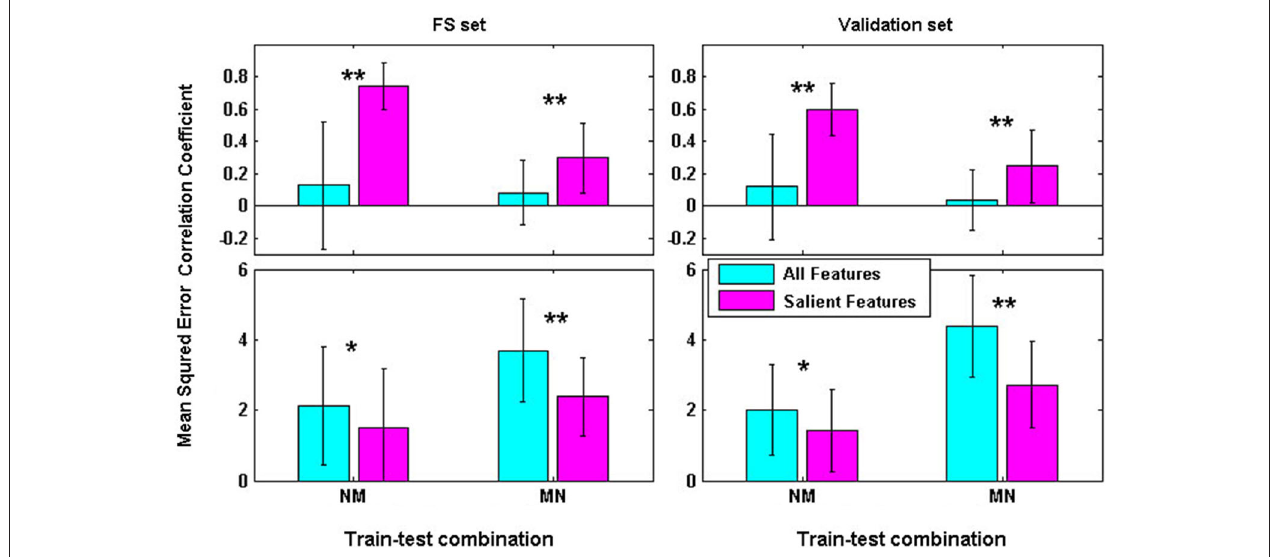
FIGURE 3 | Cross-task performances for both FS and validation data with AF and SF respectively (* : p < 0.05; ** : p < 0.01) .